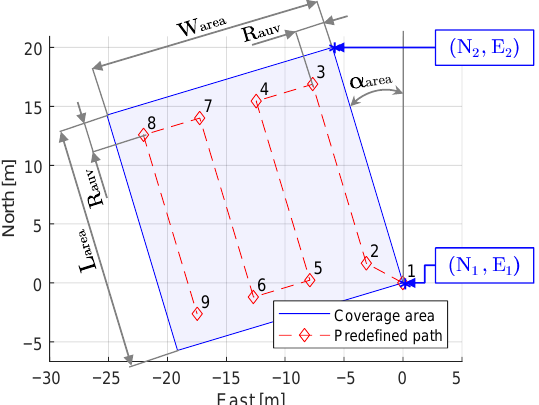
Figure 7. Coverage path definition based on Algorithm 1: Coverage path (dotted red line) is generated based on the dimensions l area , w area , and first two corners of the coverage area ( N i , E i ), along with the coverage AUV radius r AUV